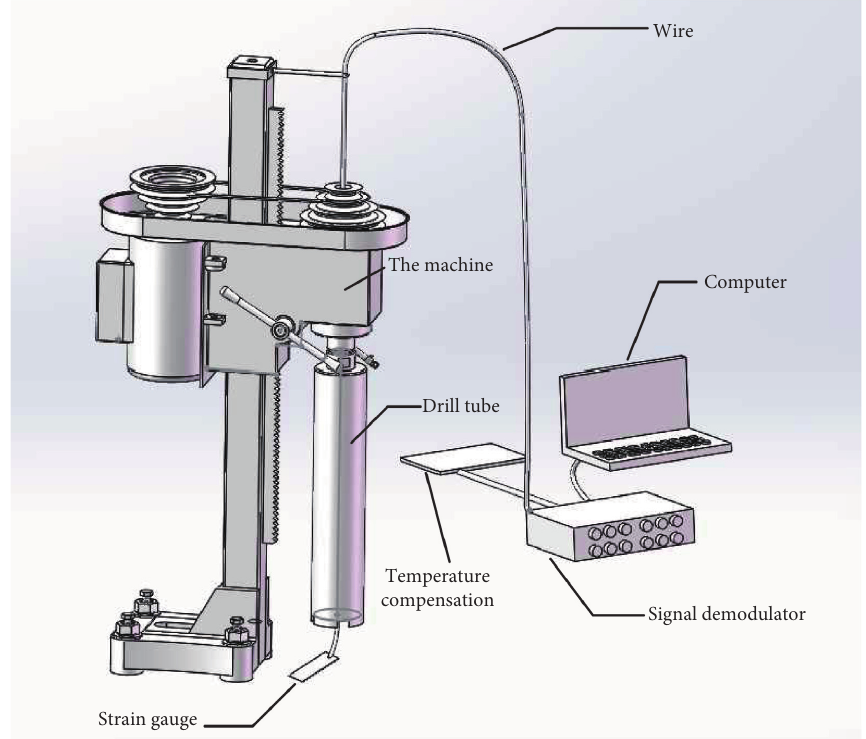
Figure 2: Special core-drilling measurement